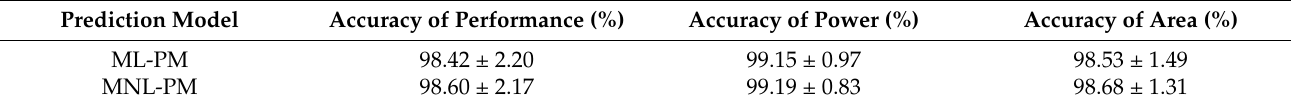
Table 4. The accuracy of the PPA prediction method. Prediction